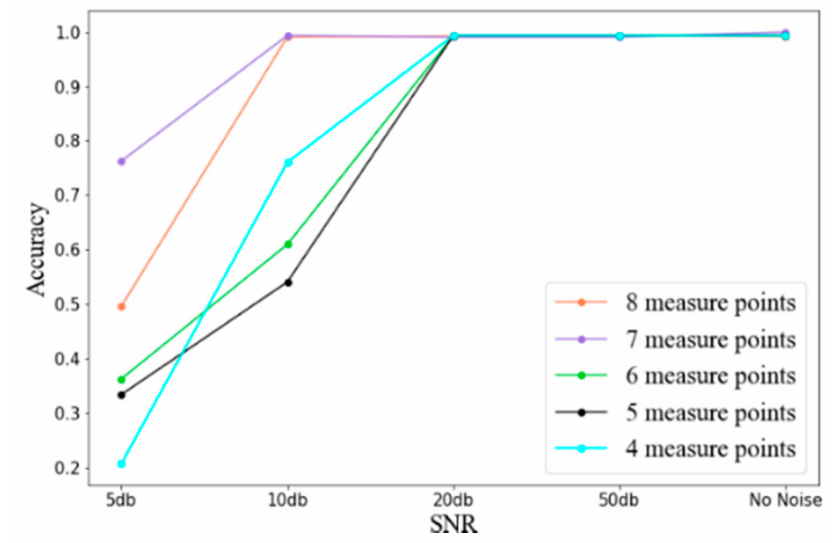
Figure 16. Comparison of the diagnosis e ff ect under di ff erent numbers of measuring points.